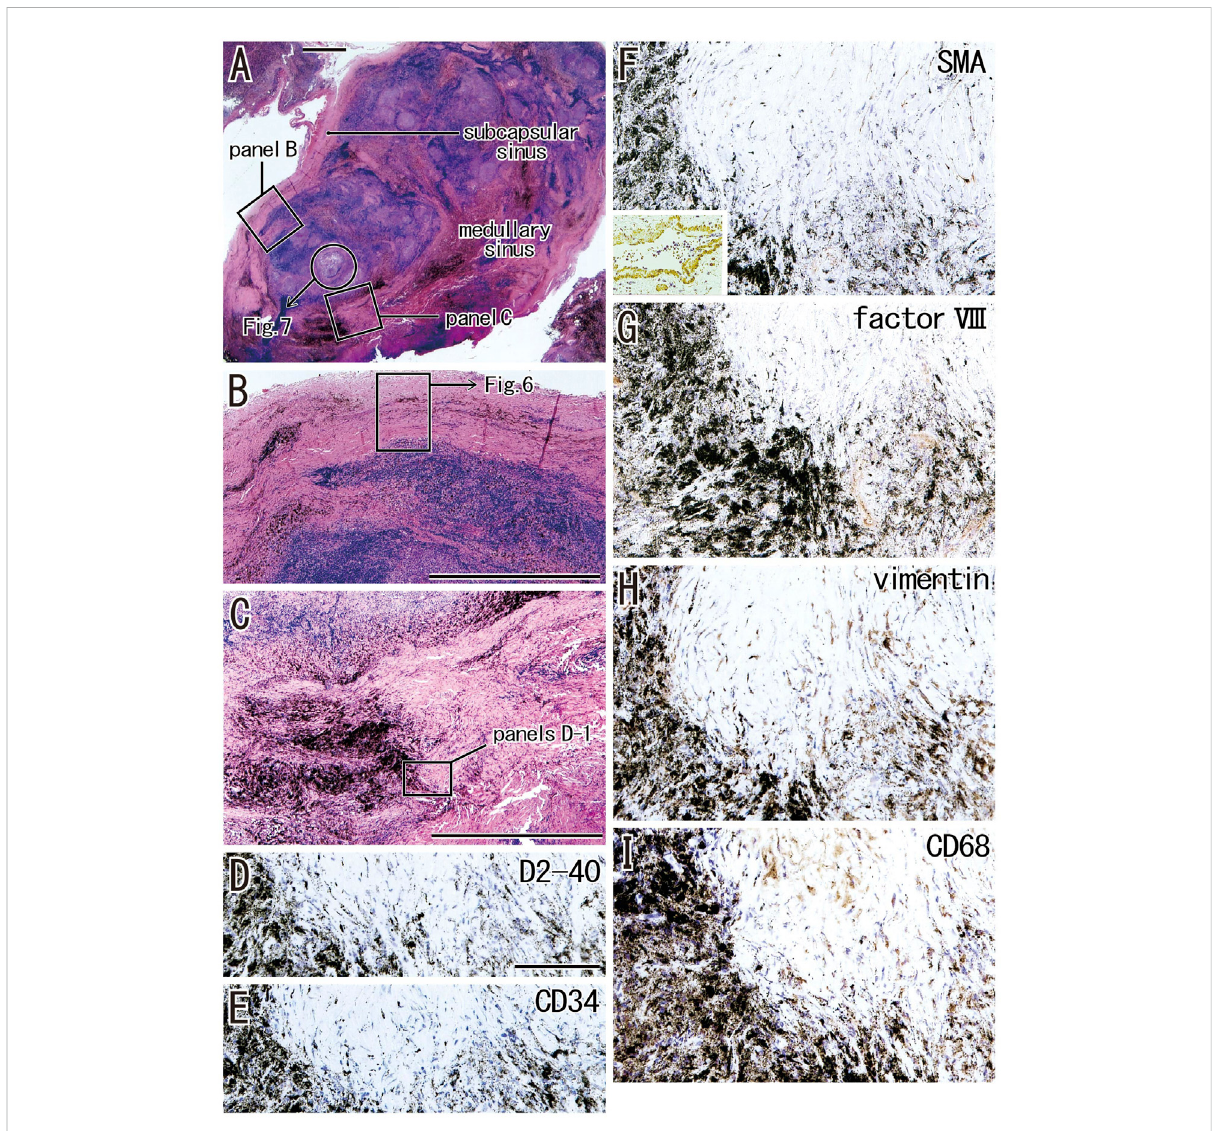
FIGURE 5 Advanced sinus hyalinization in combination with the cortex degeneration. An interlobar node removed from a 78-years-old man (smoker). Two squares in (A) are shown at the higher magni fi cation in (B) (subcapsular sinus hyalinization; immunohistochemistry, see Figure 6) and (C) (medullary sinus hyalinization). A part of the cortex [circle in (A) ] will be shown in Figure 7 with immunohistochemistry. The DAB reaction made the positivecellsbrown.Themedullarysinushyalinization,negativeforD2-40[podoplanin; (D) ]andCD34 (E) ,containsfewslendercellspositivefor smoothmuscleactin[SMA; (F) ],factorVIII (G) ,vimentin (H) orCD68 (I) .Aninsertatthelowerangleof (F) shows apositivecontrolofthepresentSMA antibody (artery found in the same section). Abundant macrophages carry carbon particles (anthracotic macrophages) and some of them are